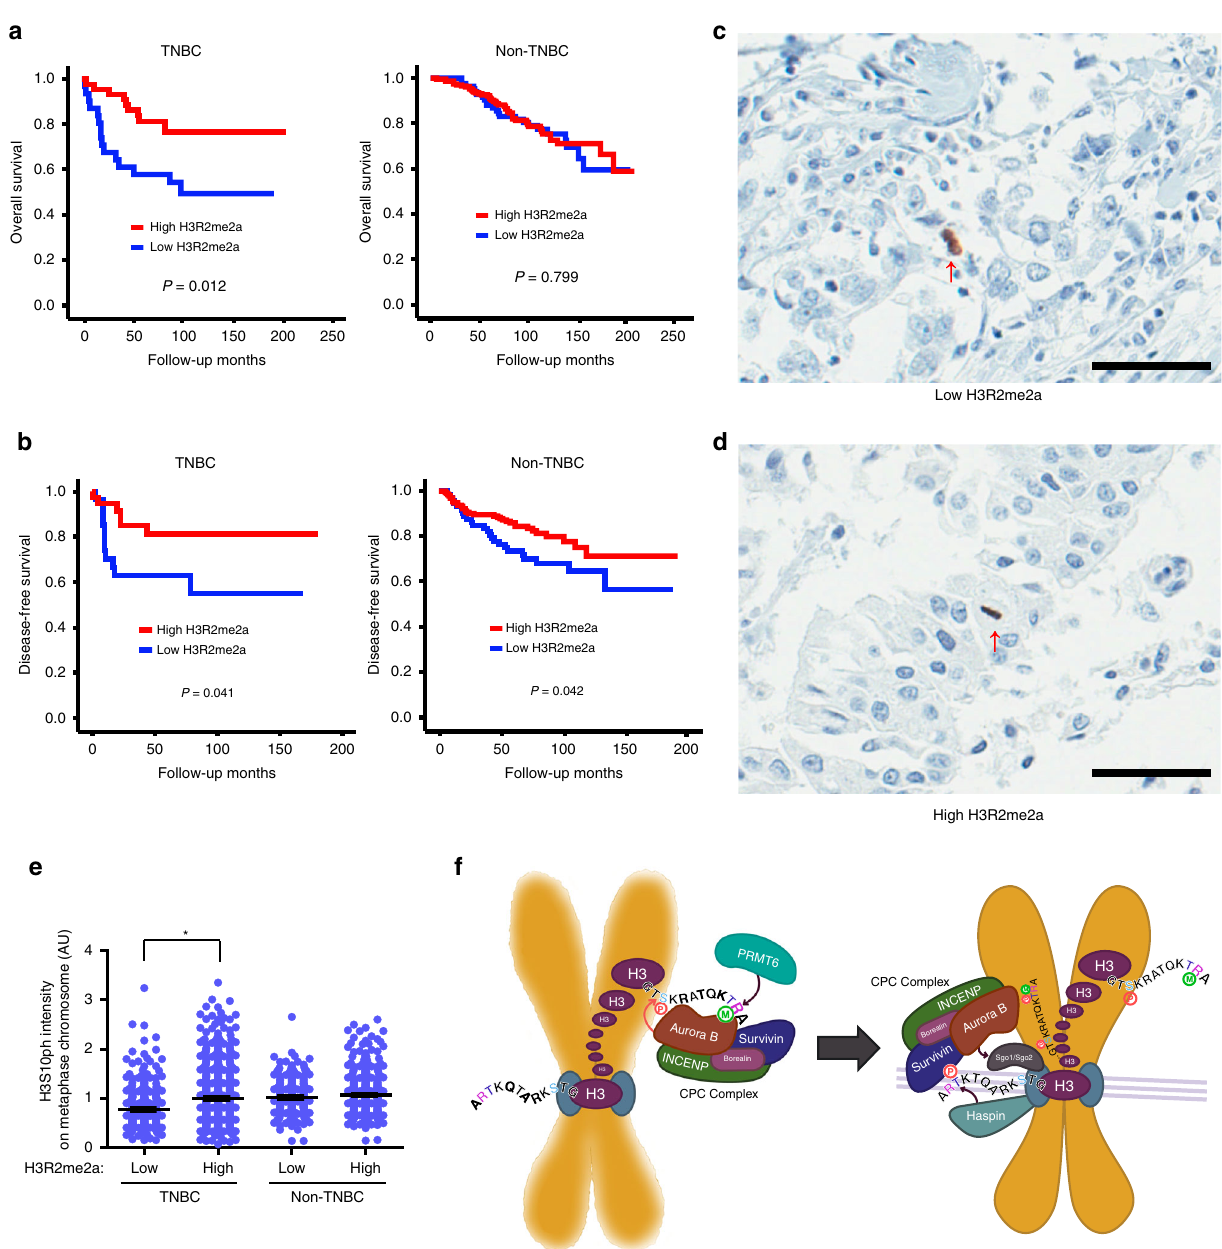
Fig. 7 H3R2me2a is associated with tumor progression. a , b Clinicopathologic characteristics of the TMA from human breast cancer patient tissues ( n = 405) in the high (staining score, 2 – 3) and low (staining score, 0 – 1) groups were quanti fi ed and plotted. c – e Immunohistochemical staining of H3S10ph in 410 human breast cancer patient tissues and normal adjacent tissues. The H3S10ph intensity in metaphase cells was quanti fi ed and plotted ( n = 327 metaphase cells for low-H3R2me2a and n = 627 metaphase cells for high-H3R2me2a tissue in TNBC; n = 245 metaphase cells for low-H3R2me2a and n = 366 metaphase cells for high-H3R2me2a tissue in non-TNBC). The arrows point to metaphase cells. Error bar, SEM. f Proposed model of the crosstalk between histone marks for the CPC positioning and chromosome condensation. Scale bars, 50 μ m. Source data are provided as a Source Data fi le. (Student ’ s t -test * p < 0.01).